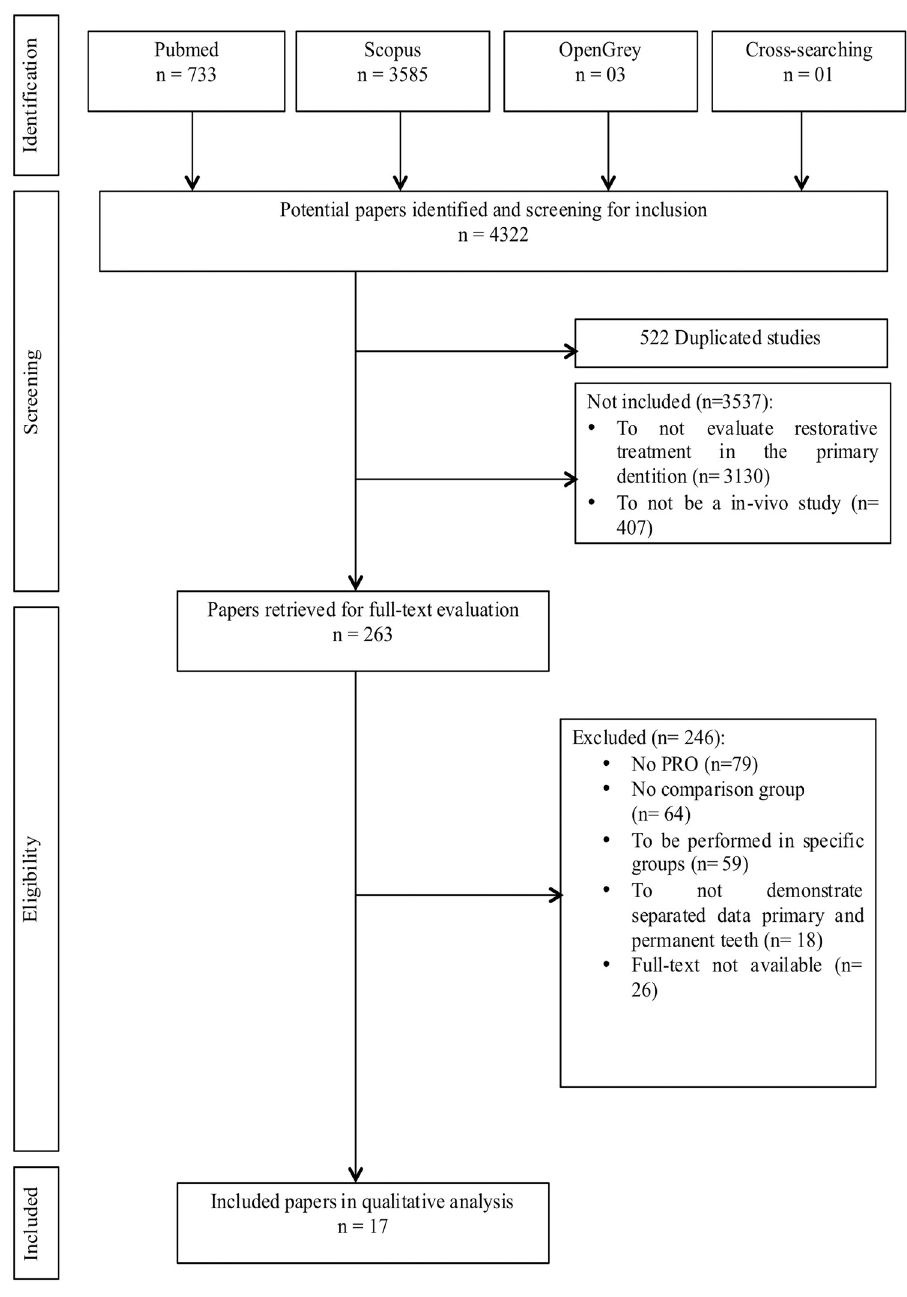
Fig 1. Flowchart of studies